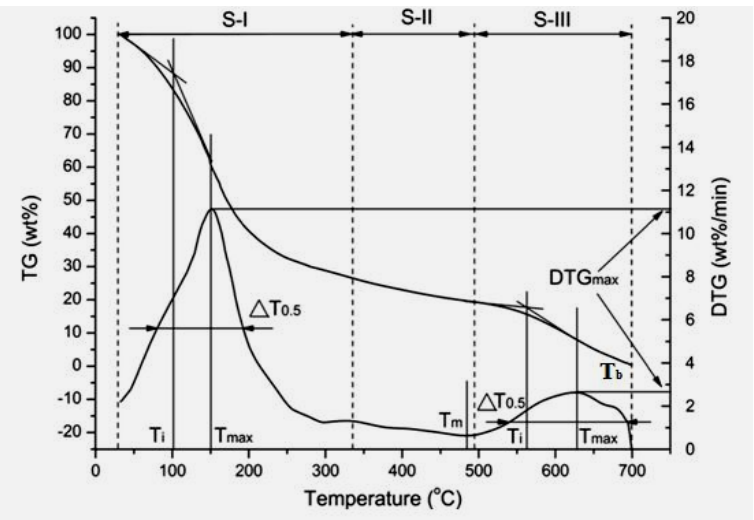
Figure 6. Combustion stages from the TG-DTG curve [120]. Table 5. Onset, offset, reaction region, maximum temperature, and weight loss biodiesels.